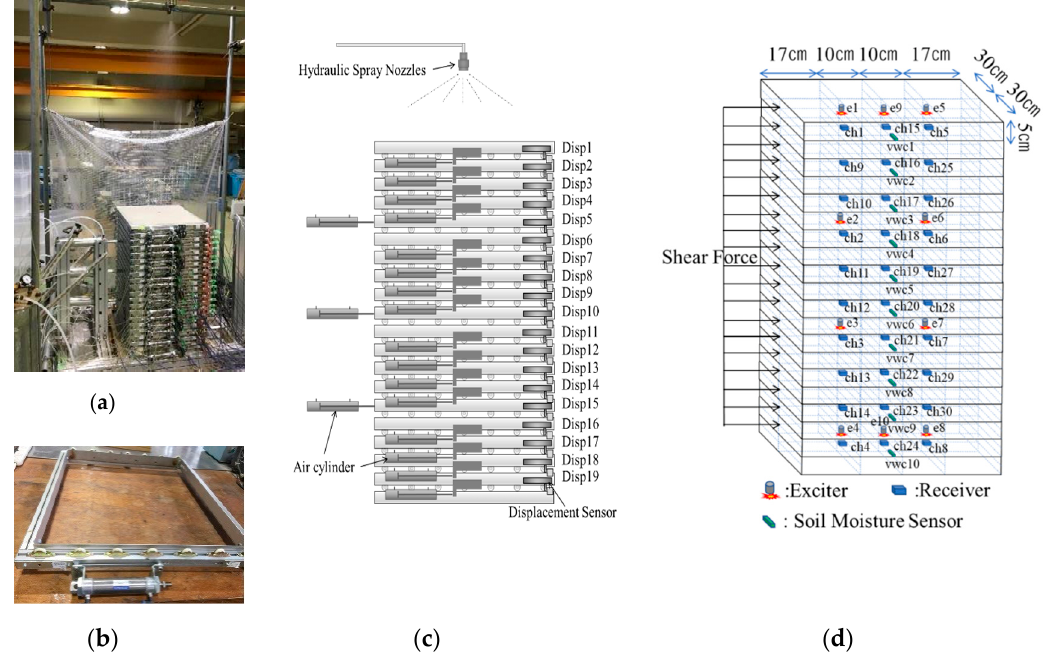
Figure 3. Multi-layer shear model and sensors layout. ( a ) A photo overview of the multi-layer shear model; ( b ) an independent frame of the multi-layer shear model; ( c ) the layout of air cylinders and displacement meters, Dis1~Dis19 are the displacement meters; ( d ) the layout of sensors in the soil. E1~E10 are the exciters; CH01~CH30 are the receivers; VWC1~VWC10 are the soil moisture sensors.